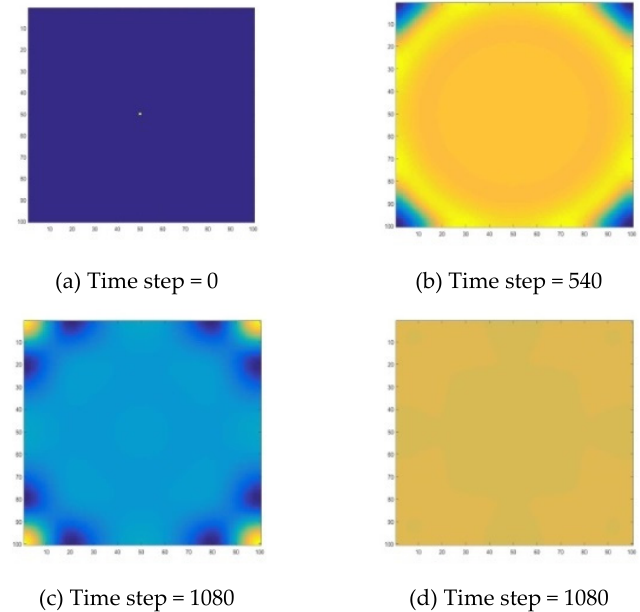
Figure 8. B-Z reaction simulation when the parameter selection is in a stable condition by PDE model.